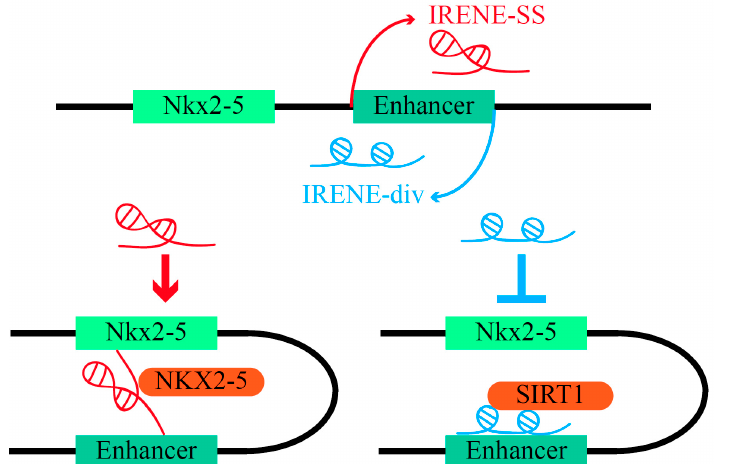
Figure 2. The opposing functions and mechanisms of IRENEs (IRENE-SS and IRENE-div) in regulating Nkx2-5 . IRENE-SS, acting as a typical eRNA, enlists NKX2-5 and upregulates Nkx2-5 expression. IRENE-div, on the contrary, recruits SIRT1 to Nkx2-5 enhancer and silences Nkx2-5 expression.